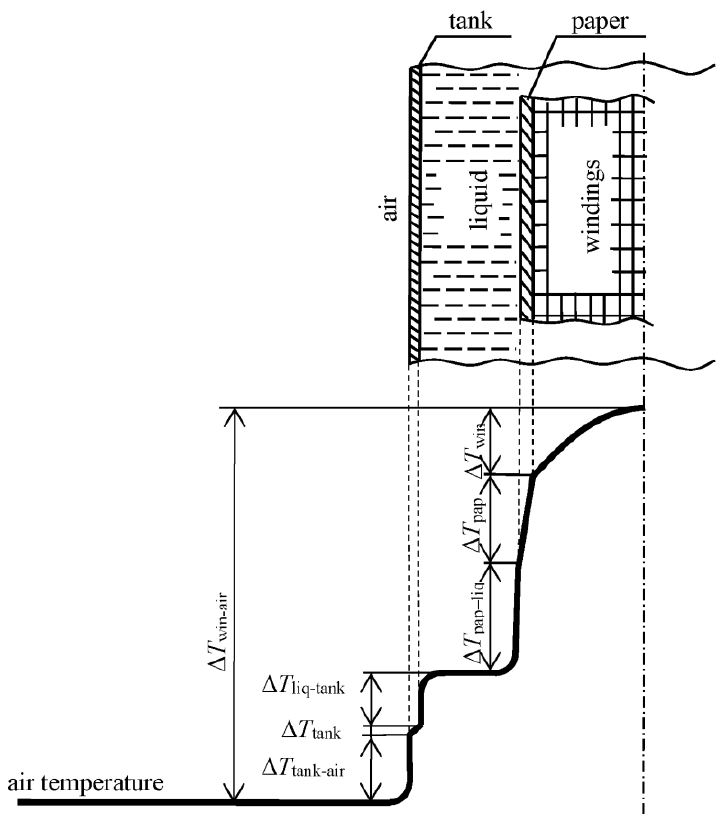
Figure 1. Temperature distribution in the power transformer on all elements of the cooling system.